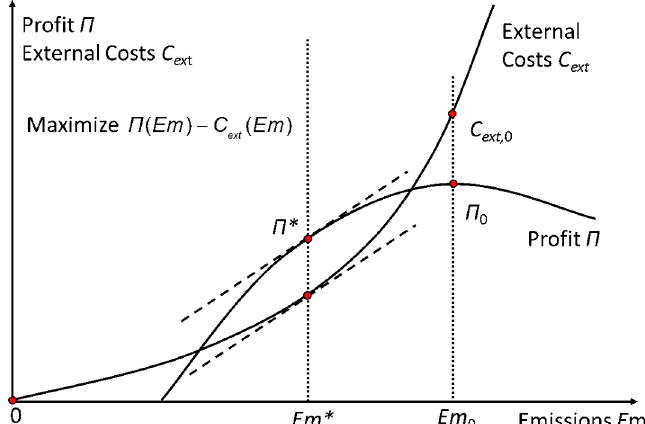
Fig. 1. – Optimal emission